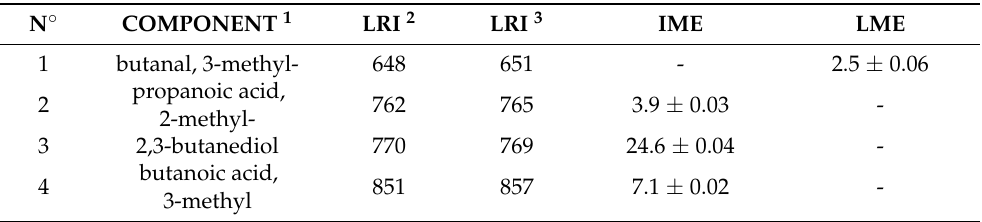
Table 3. Chemical volatile composition (percentage mean value ± standard deviation) of methanolic extracts from hops inflorescences and leaves, as determined by GC-MS. N